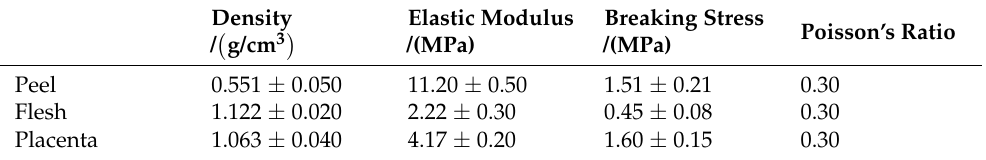
Table 1. Kiwifruit mechanical